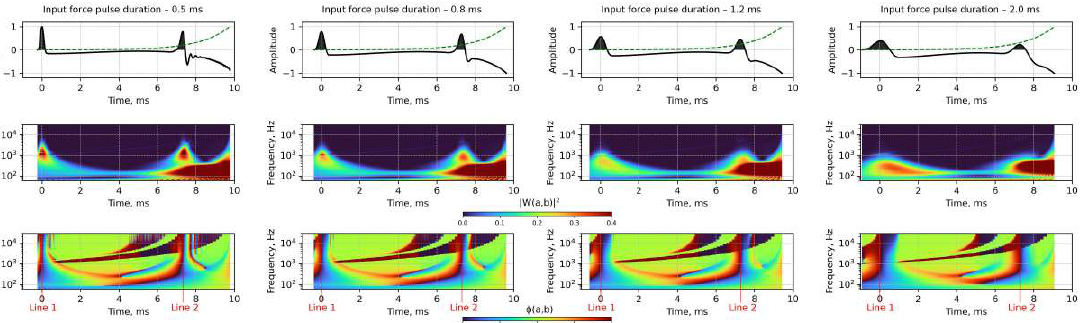
Figure 4. CCWT analysis of the low strain test numerical simulation results for a single-section pile (Model 1) with input force pulses of 0.5, 0.8, 1.2, and 2 ms duration. 1st row—the simulated signals, 2nd row—the distribution of energy of the wavelet transform coefficients, 3rd row—the distribution of phase angles of the wavelet coefficients. Lines 1 and 2 delineate the phase shift moments.